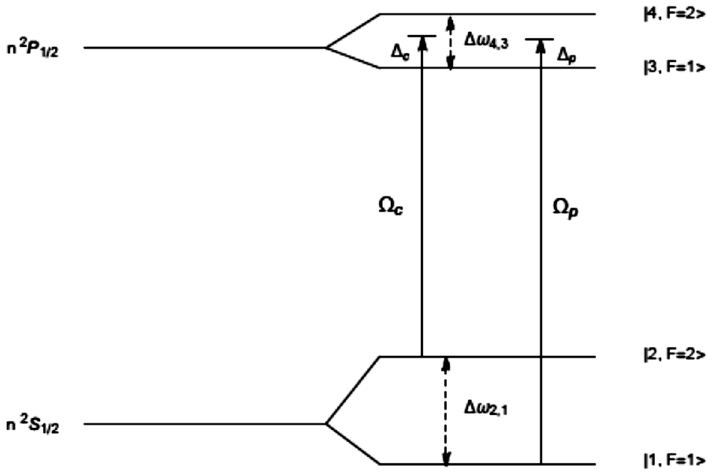
Figure 1. Optical transitions in the D 1 line hf-structure for 23 Na, 87 Rb, and 39 K vapours. The experimental data were taken from [22–25]. In detail, the experiment data for potassium were taken from [25] and those sodium from [23]. Furthermore, the experimental data for rubidium were found in [24], whereas the updated data were taken from